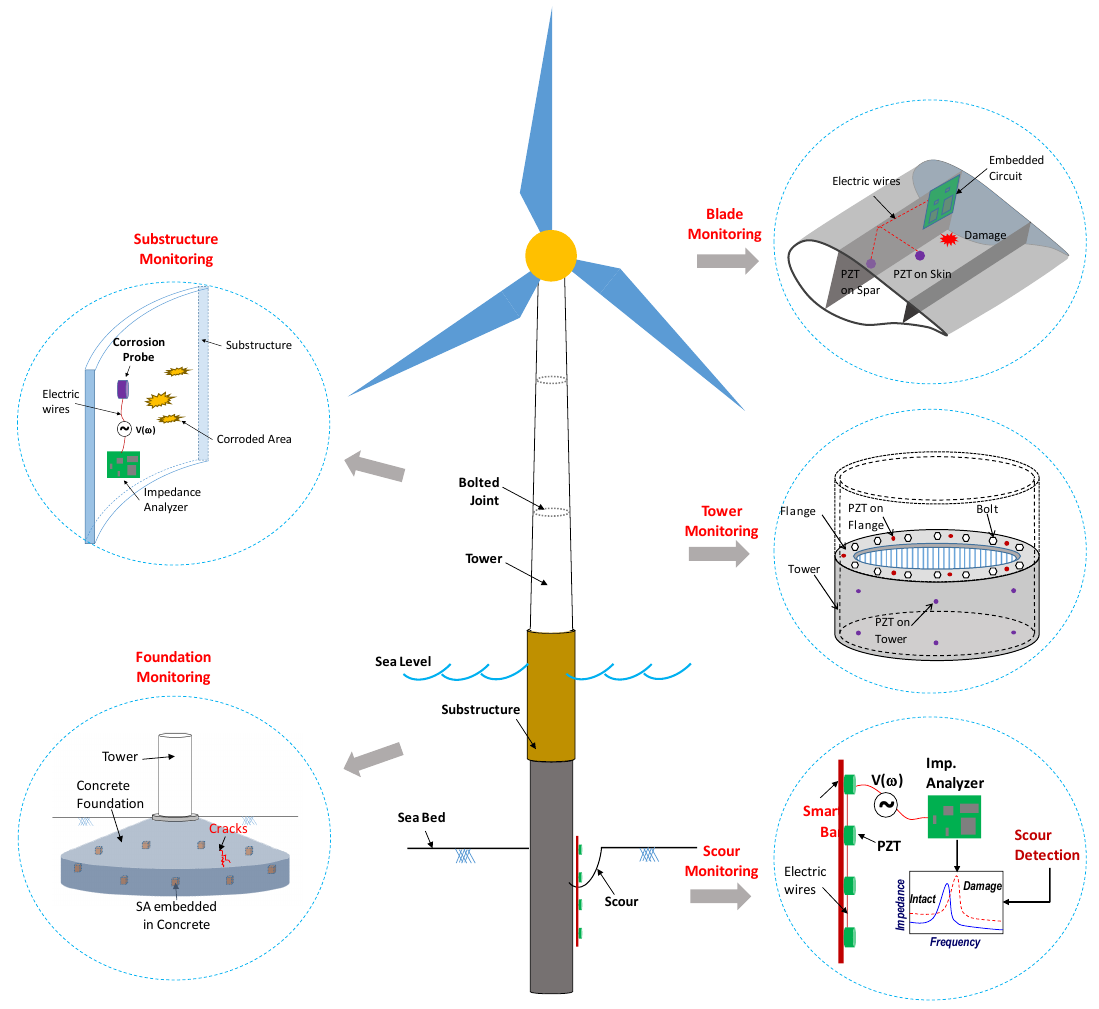
Figure 17. Impedance-based SHM of wind turbine structures.